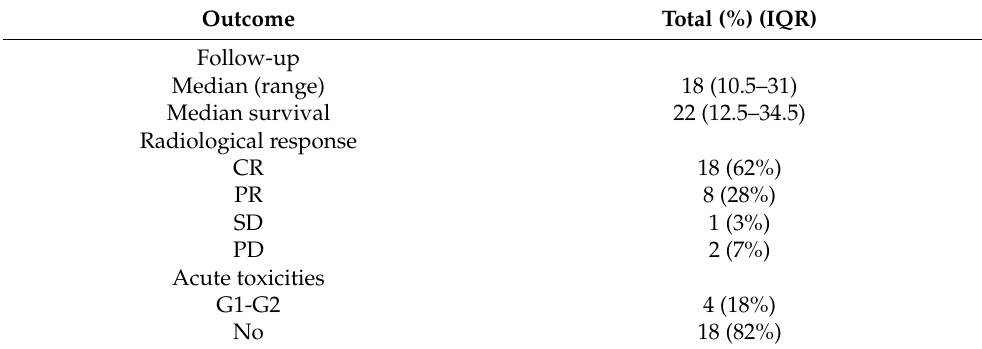
Table 3. Treatment